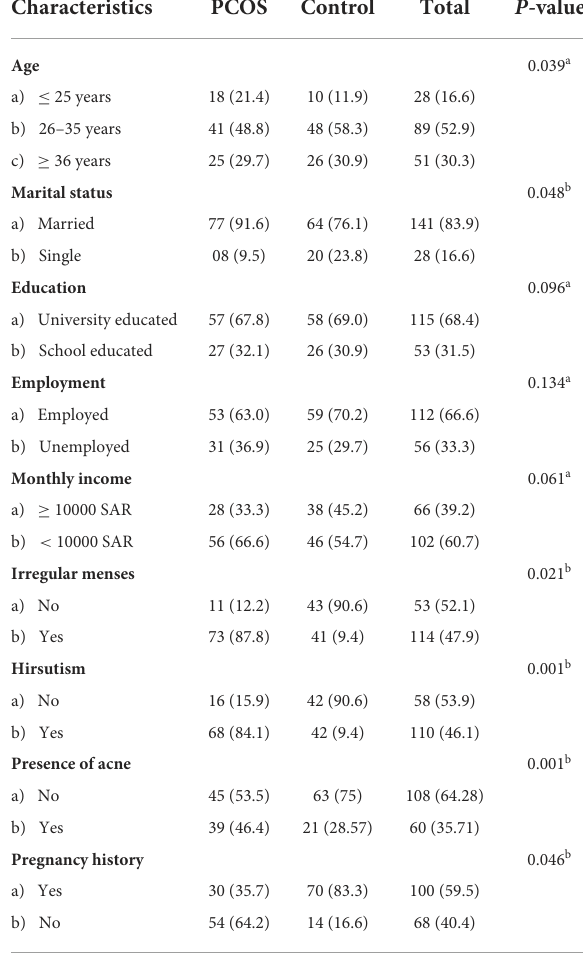
TABLE 1 The association between sociodemographic characteristics and PCOS ( n , %).